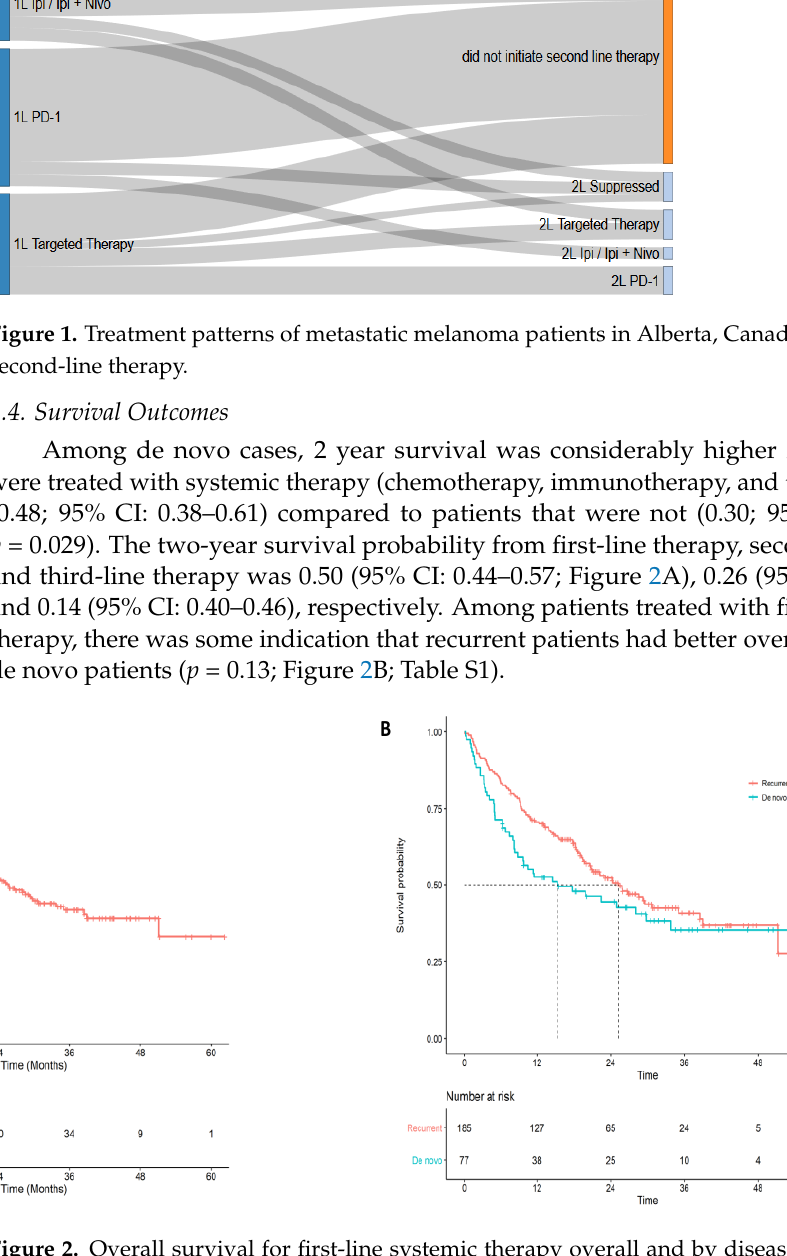
Figure 2. Overall survival for first-line systemic therapy overall and by disease type ( A ) Overall survival for all patients that initiated first-line systemic therapy. ( B ) Overall survival for first-line systemic therapy by disease type (de novo vs. recurrent).